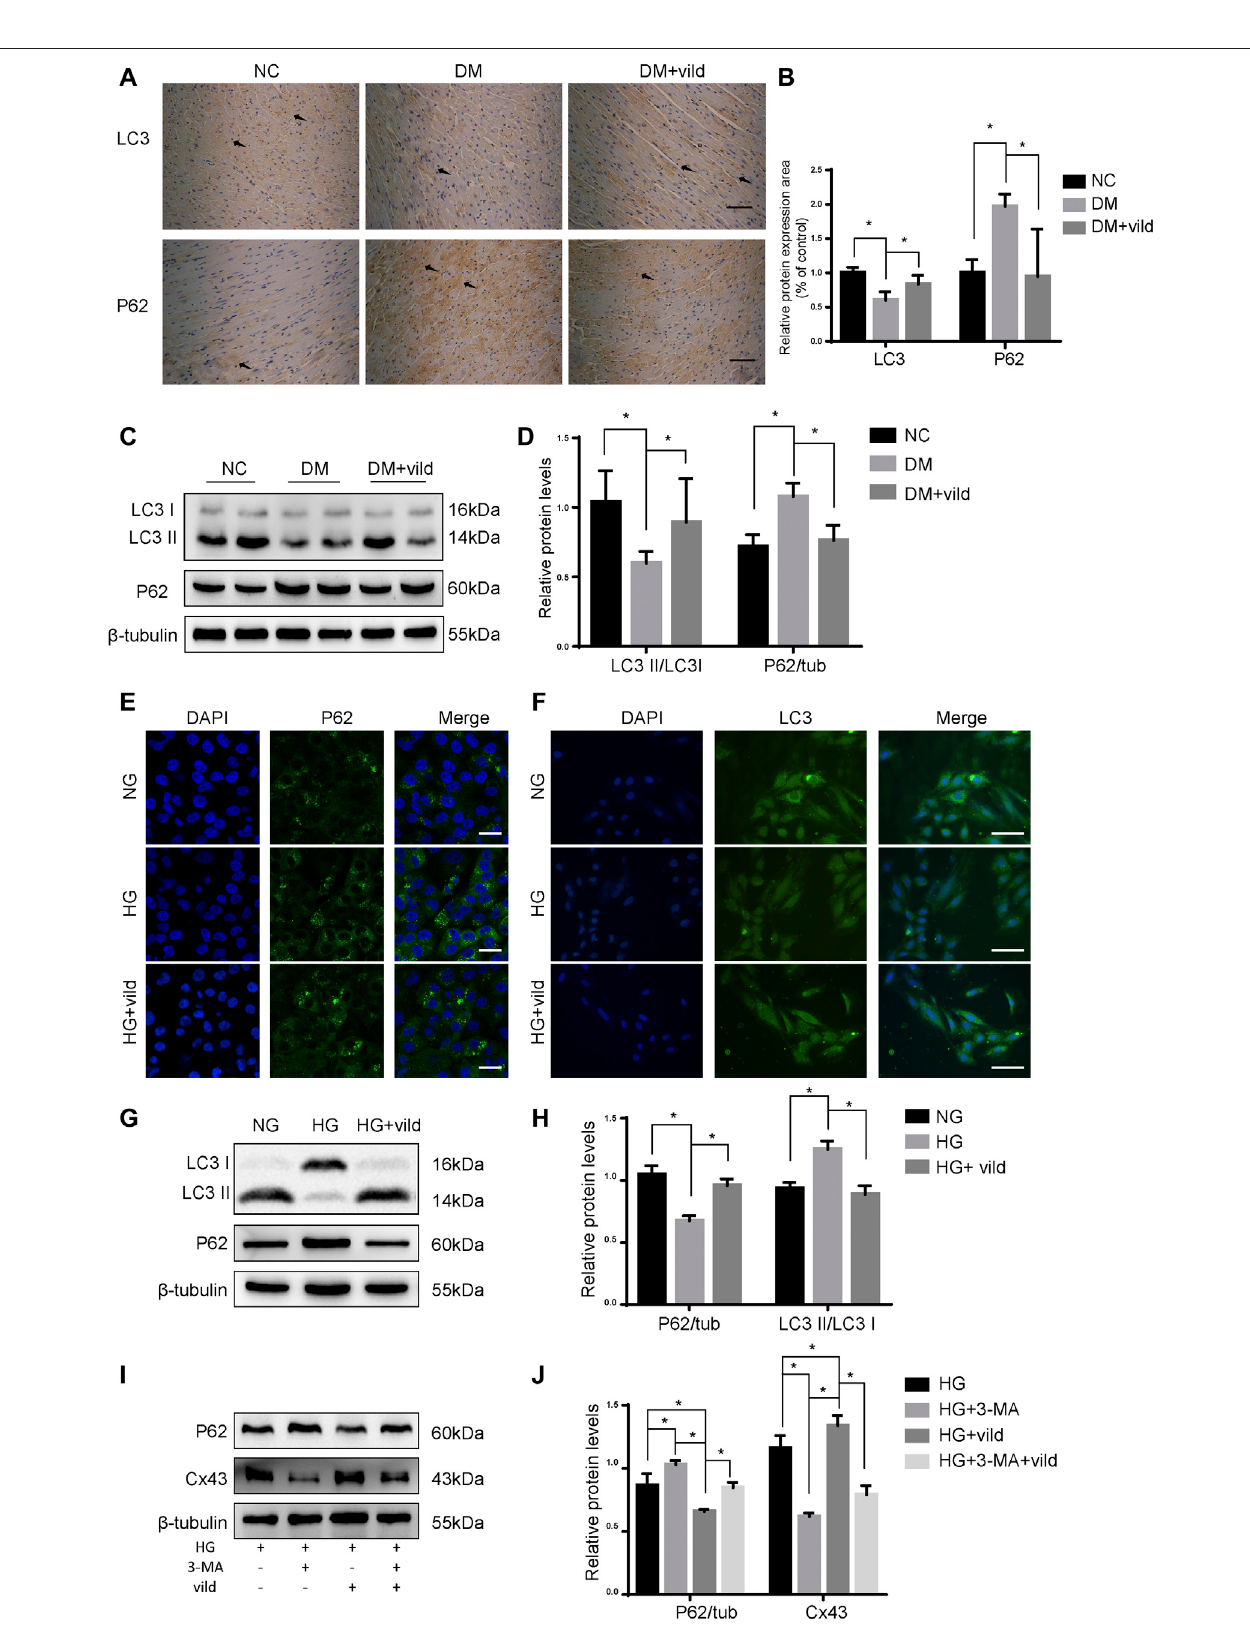
FIGURE 2 | Vild treatment restores autophagy in vivo and in vitro . (A) Immunohistochemical staining of P62 and LC3 in cardiac sections. Scale bars in the right